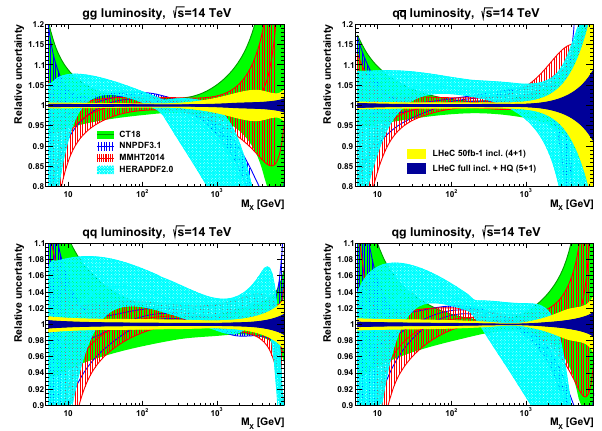
Fig. 1 Expectedprecisionforthedeterminationofparton-partonlumi- nosities as function of M X in Drell–Yan scattering at the 14 TeV LHC. Light blue: HERA, yellow: initial LHeC run, dark blue: full LHeC data set, overlayed with three, recent global fit results. For more information see